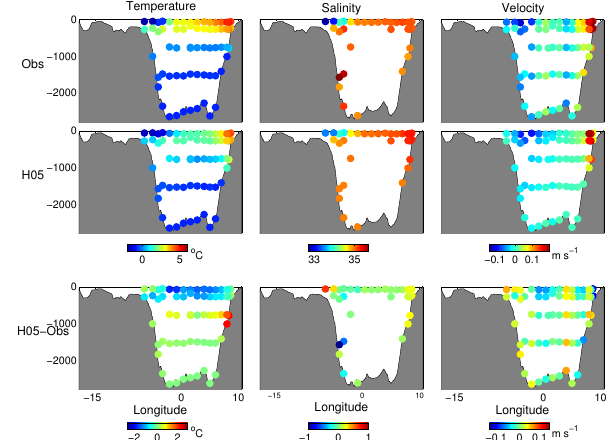
Figure 10. The mean observed (top), modelled (hindcast H05, mid- dle) and difference (modelled minus observed, bottom) tempera- ture (left), salinity (middle) and northward velocity (right) in Fram Strait.